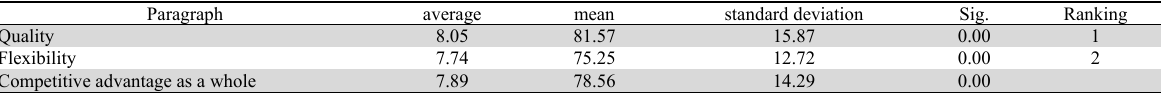
The arithmetical averages and standard deviations related to the competitive advantage of its dimensions are ranked as im- portant